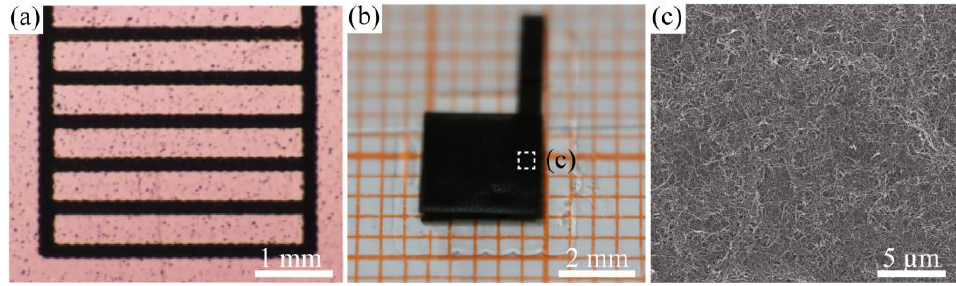
Figure 8. Optical microscope images of a printed ( a ) micro-ribbon and ( b ) patterned PVA-CNT thin film. ( c ) SEM image of the printed CNT film on the preprocessed PVA film. All patterns were obtained by overwriting 6 layers of CNT lines on 55 °C-9 min PVA films in the aforementioned staggered strategy.